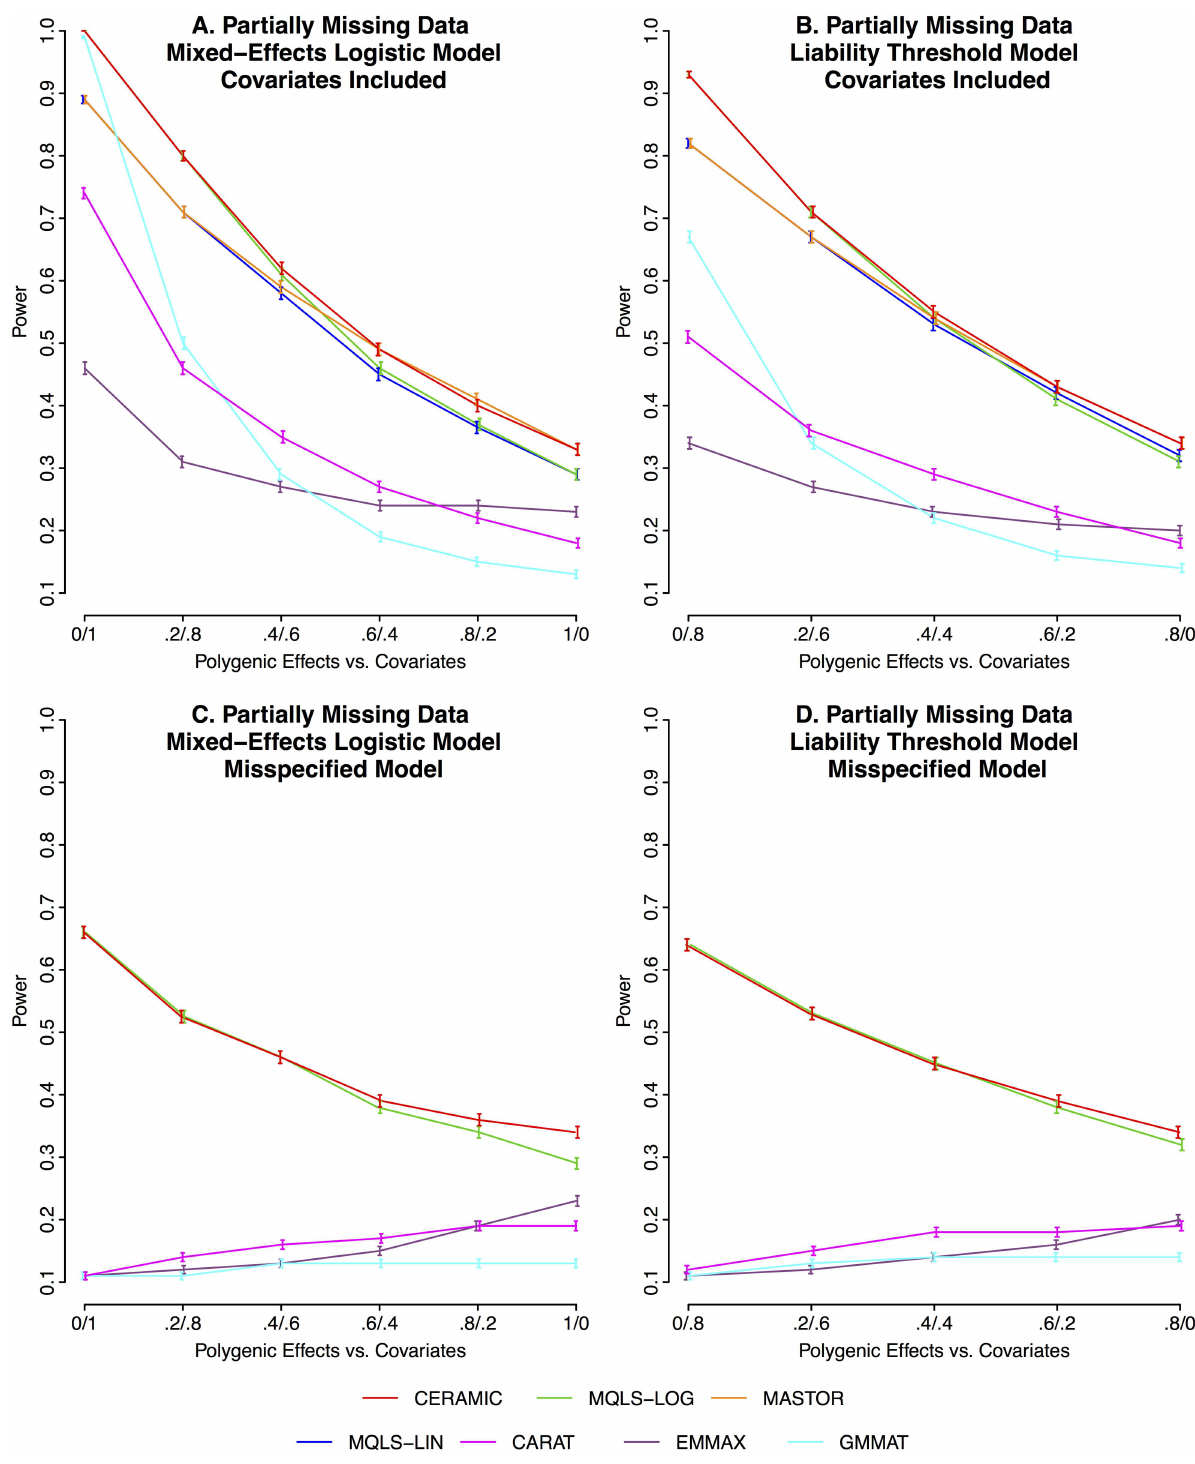
Fig 2. Empirical Power of CERAMIC and Other Methods. Empirical power is based on 10,000 replicates. The error bars indicate 95% confidence intervals. Panels A and B are for the case in which all relevant covariates are included in the fitted model. Panels C and D are for the case in which the relevant covariates are not includedin the fitted model. In Panels A and C, the trait is simulated by the mixed- effects logistic regressionmodel, and it Panels B and D, it is by the liability threshold model. The horizontalscale in the plots indicates the relative impact of covariates versus additive polygeniceffects on the phenotype, with the far left corresponding to no polygenic effects